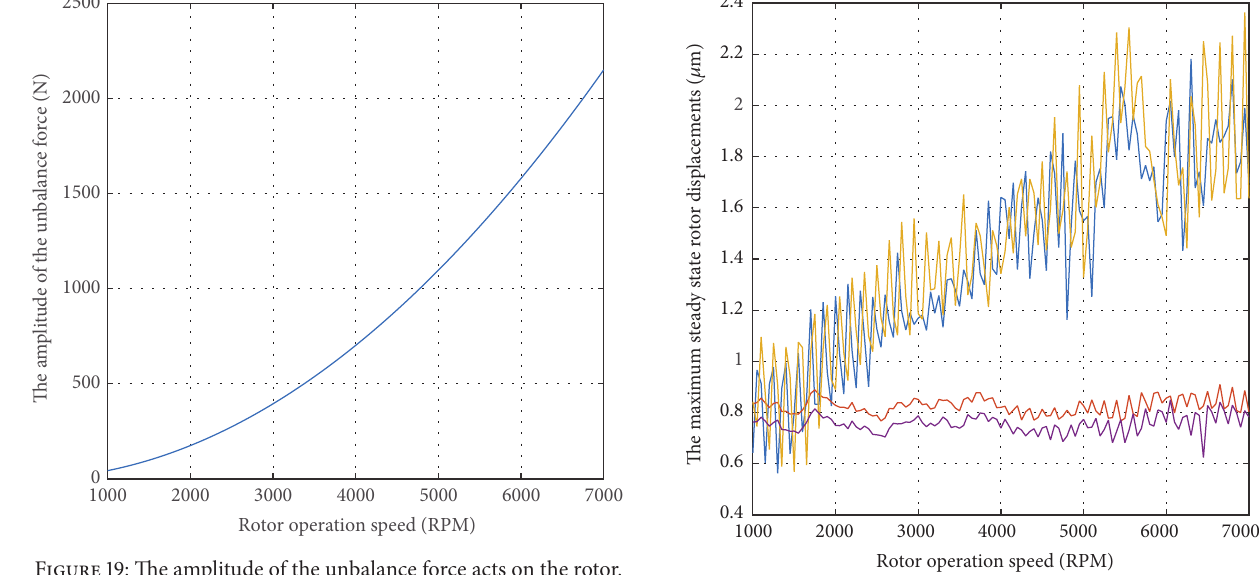
Figure 19: The amplitude of the unbalance force acts on the rotor.